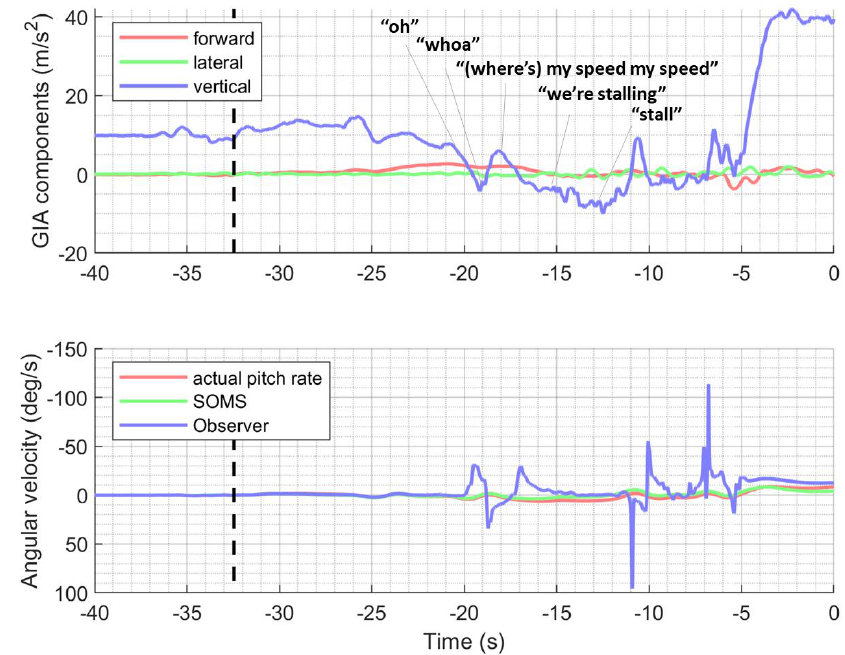
Figure 5. Time histories of the recorded GIA components ( upper panel , m/s 2 ) and actual and predicted pitch rate ( lower panel , deg/s). The PF’s callouts in the upper panel were copied from Appendix D within reference [1].